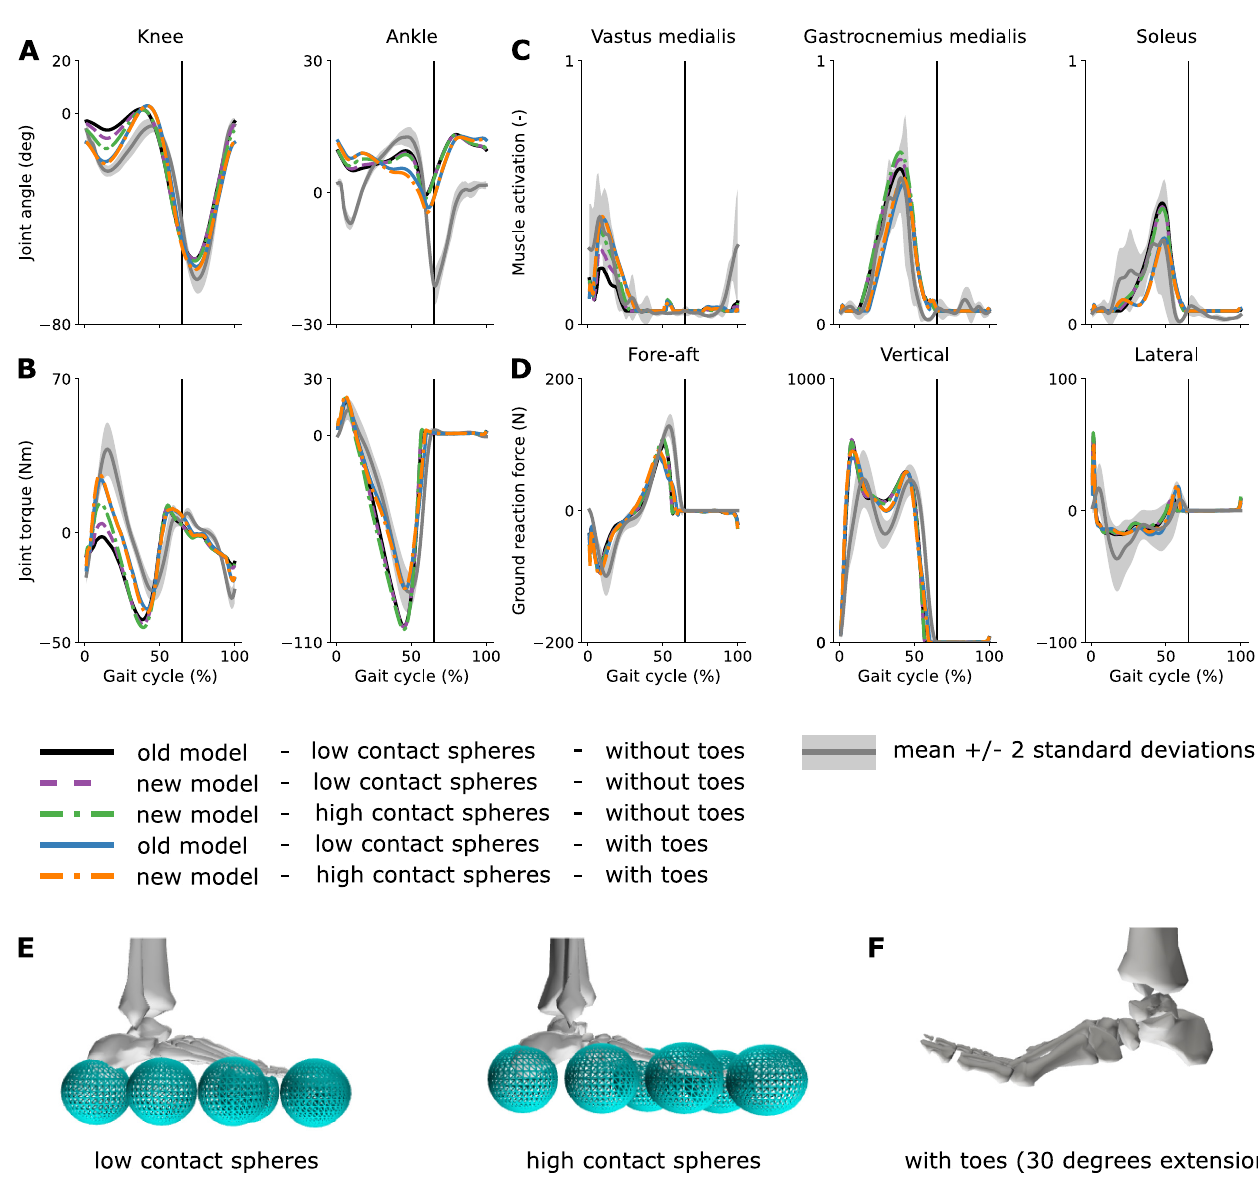
Fig 1. Influence of modeling choices on predicted gait pattern. Predicted knee and ankle kinematics ( A ) and kinetics ( B ), muscle activations ( C ), and ground reaction forces ( D ) with the different models. Experimental data (shaded areas) are shown as mean ± 2 standard deviations. The experimental electromyography data were normalized to peak activations of the new model with high contact spheres and with toes (dashdot orange curve). The vertical black lines indicate experimental stance to swing transition. The old and new models have the same mass but different mass distribution: the new model having a lighter torso, but heavier legs as compared to the old model. The difference in the vertical position of the contact spheres (about 1 cm) is illustrated in ( E ), and an example toe extension is depicted in ( F ). Results for all joints and muscles are shown in S1–S3 Figs.